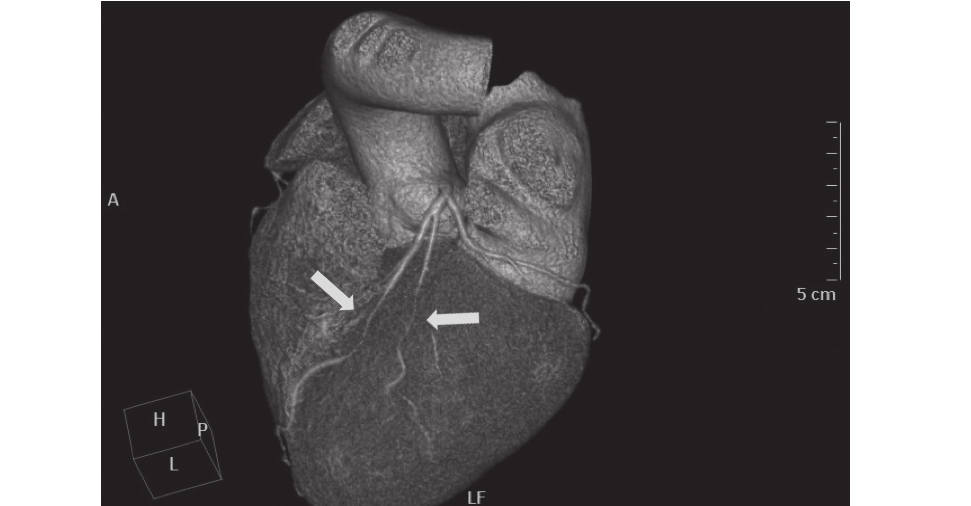
Figure 2. Coronary computed tomography angiography (CCTA) showing two myocardial bridges of the left coronary